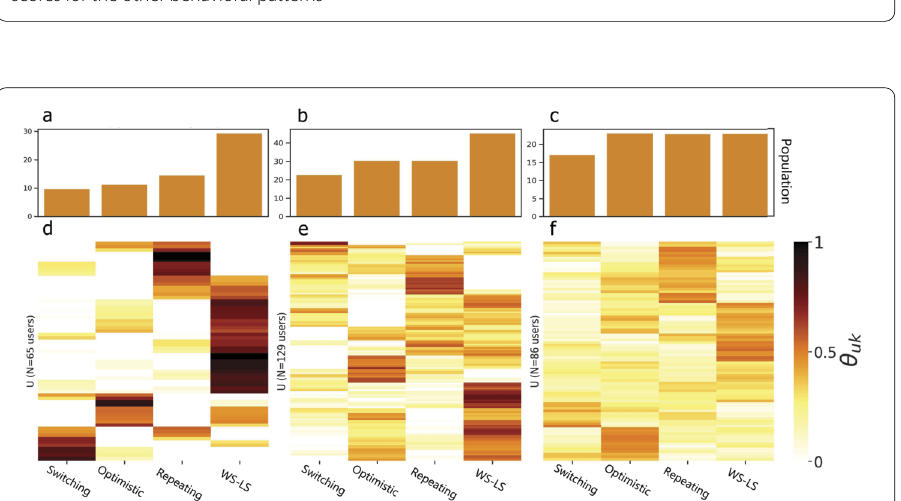
Figure 6 Distribution of use of behavioral patterns by players We compute the Shannon entropy of the θ membership vectors among four behavioral patterns: switching, optimistic, repeating, and win-stay (WS-LS). We split the users according to their Shannon entropy: ( a ), ( d ) Low entropy, including players who typically do not mix elementary strategies; ( b,e ) Medium entropy, including players who mix two or three elementary strategies; ( c ), ( f ) High entropy, including players mix three or four elementary strategies. ( a ), ( b ), ( c ) Use of each elementary strategy for players with membership vectors with low, medium and high entropy users, respectively. ( d ), ( e ), ( f) Membership vectors. Each row represents one player. The color code quantifies the extent to which a player uses a behavioral pattern. We observe that the win-stay loose-Shift strategy is widely used alone, and that optimistic is commonly used in combination with other behavioral patterns